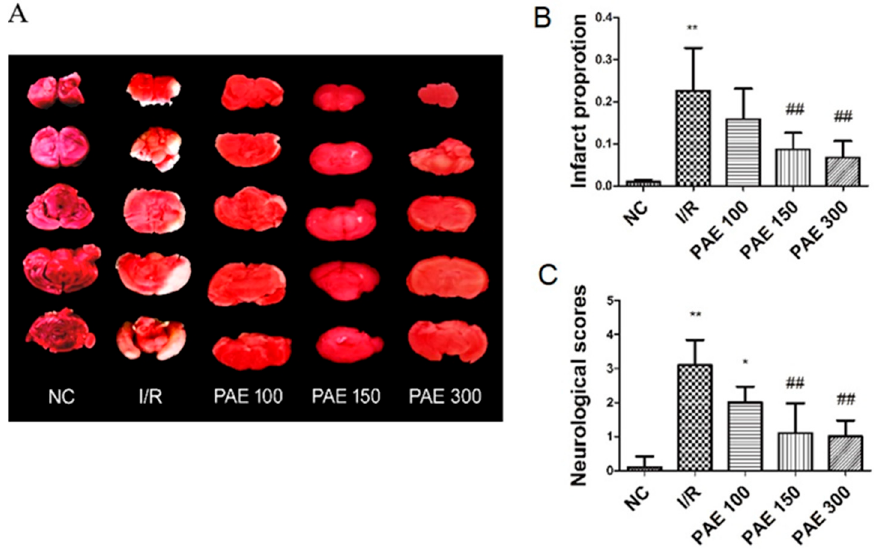
Figure 4. Effect of purified anthocyanin extracts (PAEs) from Dongkui Myrica rubra on neurological deficits and on cerebral infarct volumes in experimental mice (triphenyl tetrazolium chloride (TTC) stain, infarction remains unstained). The quantification of ( A ) is shown in ( B ); ( C ) neurological deficit scores. The data are expressed as mean ± SD ( n = 10); * p < 0.05, ** p < 0.01 vs. negative control (NC) group; ## p < 0.01 vs. I/R group.